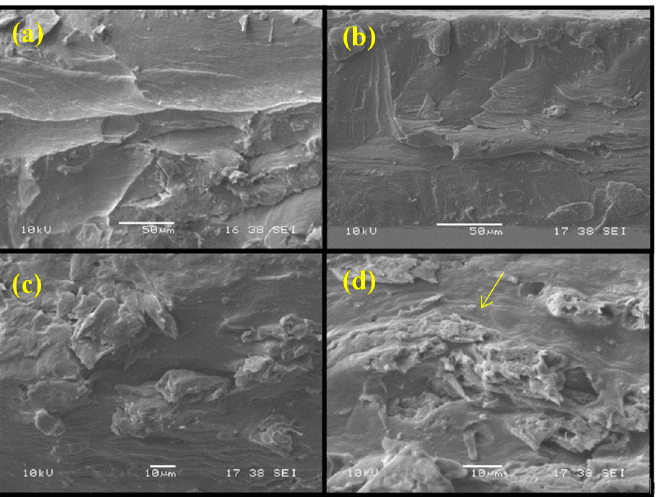
Figure 2. Scanning electron microscopy images of cross-section of the ( a ) alginate; ( b ) alginate with 5 wt % CNF; ( c ) alginate with 10 wt % CNF; and ( d ) alginate with 15 wt % CNF films (arrow indicates the CNF agglomeration in alginate matrix).